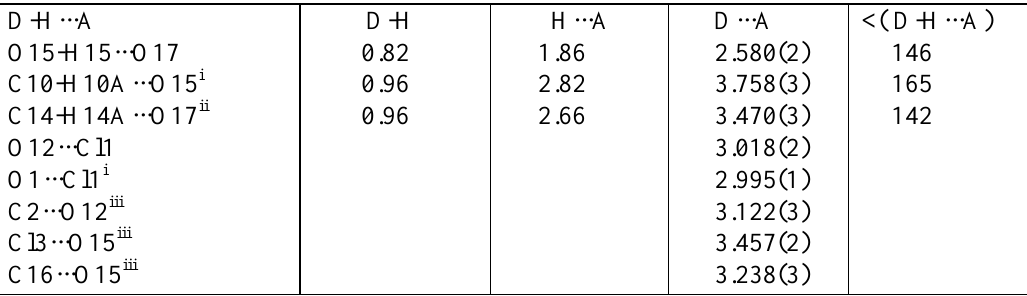
Table 2. Intra- and intermolecular interactions in crystals of VI (Å,